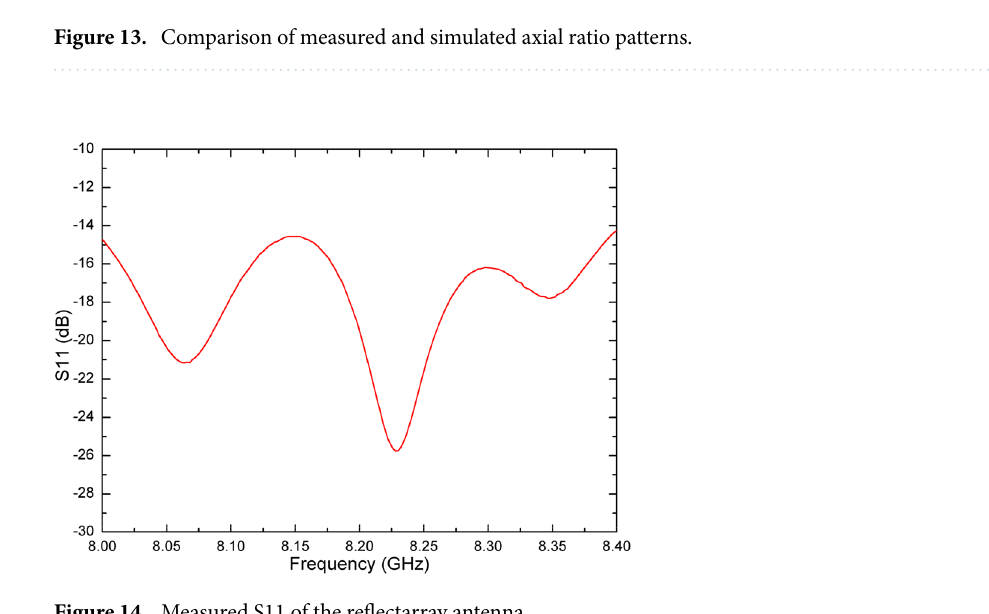
Figure 14. Measured S11 of the reflectarray antenna.